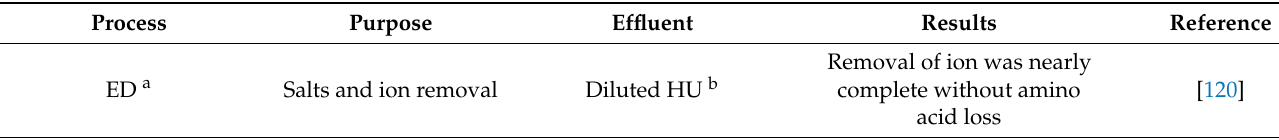
Table 6. Electrodialysis